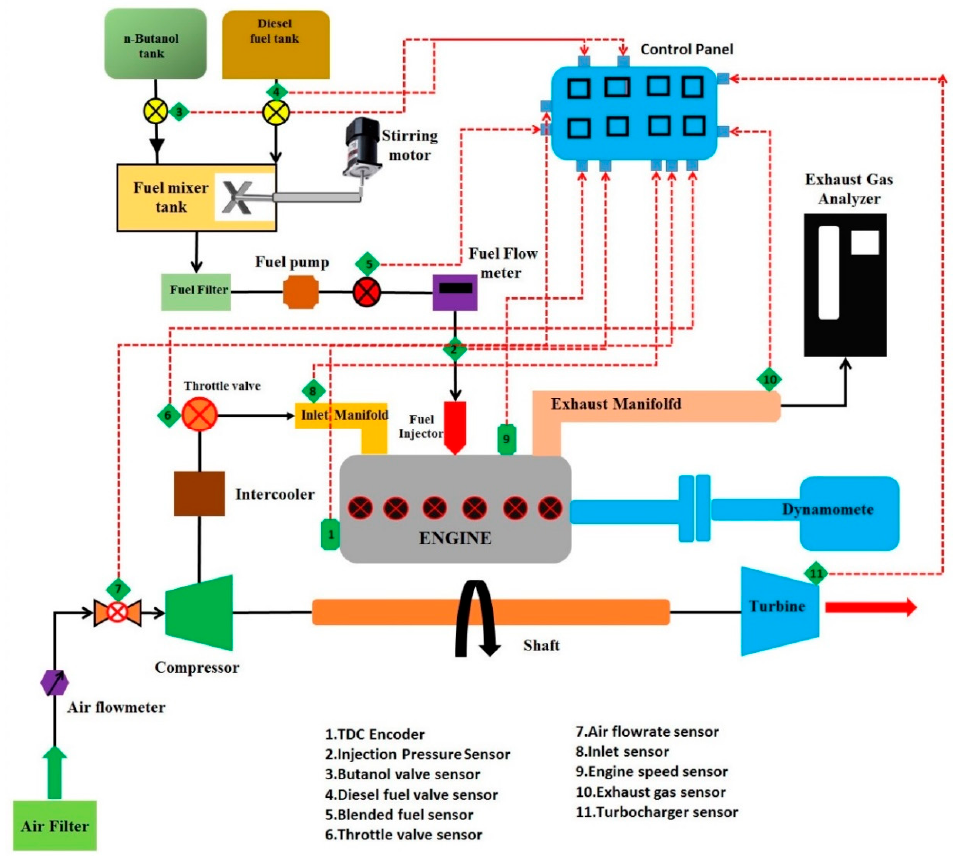
Figure 1. Engine model.